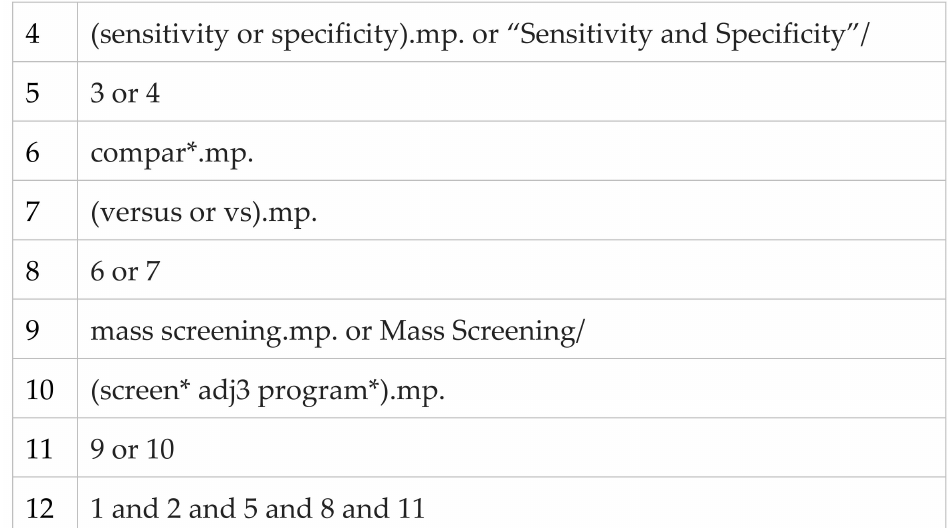
Figure 3. Medline Search Strategy. asterisk (*) represents a truncation search.